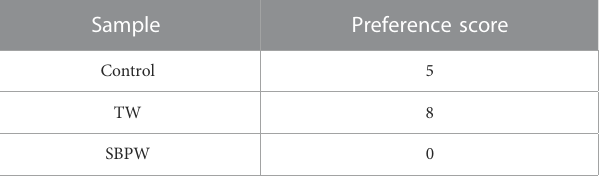
TABLE 4 Preference scores of mashed potato